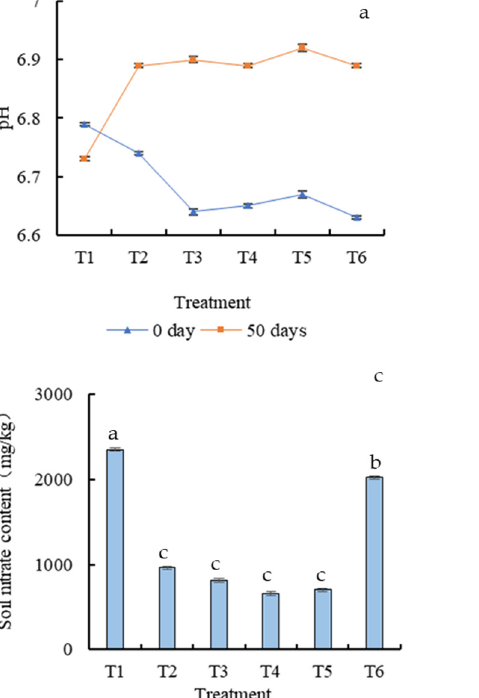
Figure 4. Soil pH ( a ) and EC ( b ) change at different growth times. Soil nitrate content at 50 days ( c ). Different letters in the same column indicate statistically significant differences among the samples based on one-way ANOVA (LSD, p < 0.05).